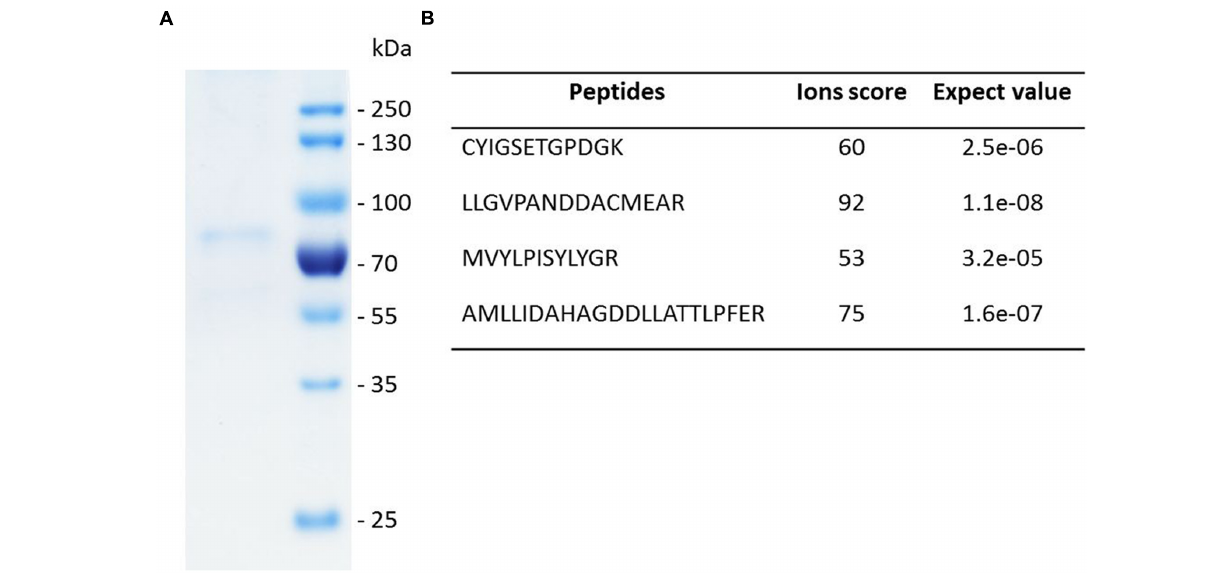
FIGURE 4 | SDS-PAGE analysis and identity confirmation of the recombinant Sp LASA protein. (A) The recombinant protein expressed in E. coli was purified by immobilized metal ion affinity chromatography (IMAC). (B) The identity of the Coomassie blue-stained SDS-PAGE band was confirmed by mass spectrometry analysis after in-gel partial proteolysis with trypsin. The peptides identified unequivocally confirmed that the purified recombinant protein corresponds to Sp LASA. The corresponding spectra are presented in Supplementary Figure